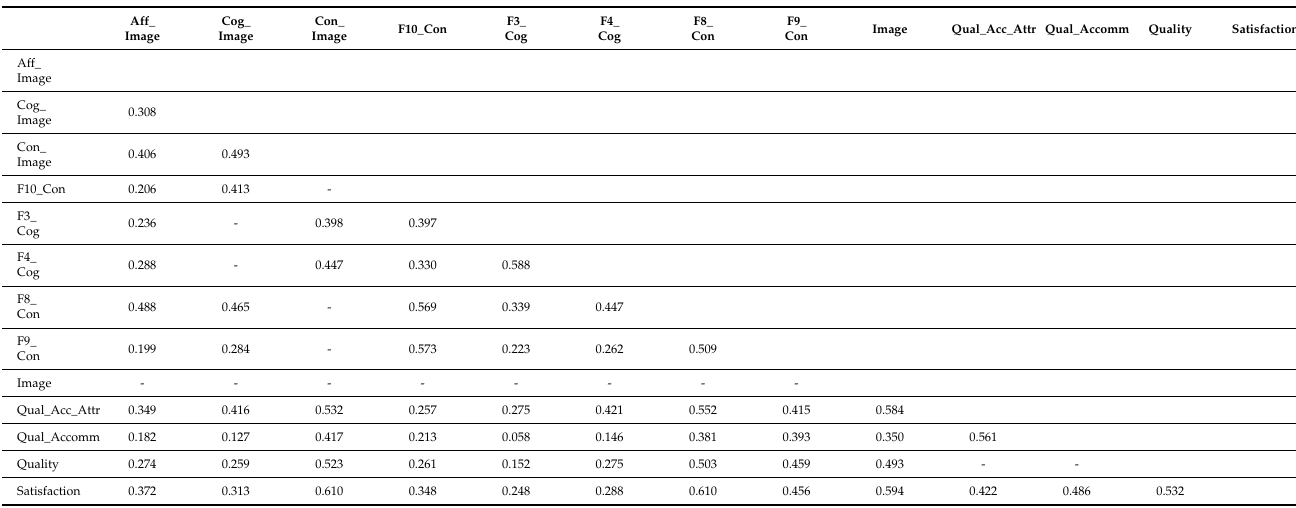
Table A7. Statistical presentation of HTMT results.